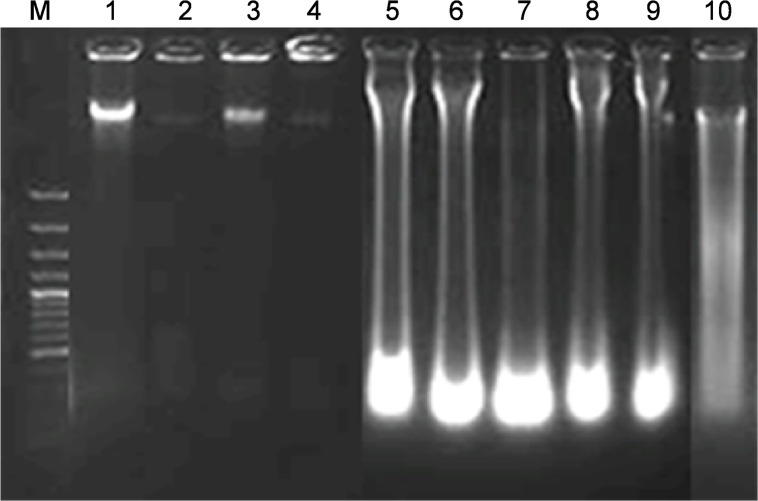
Agarose gel electrophoresis of extracted DNA from liver of rats.Results of the DNA fragmentation assay confirm that pretreatment with chicory extract attenuates CCl4-induced hepatotoxicity in rats. Lane M, DNA ladder; Lanes 1–2, untreated control group; Lanes 3–4, chicory extract-treated group; Lanes 5–9, CCl4-treated group, and Lane 10, chicory extract+CCl4-treated group.